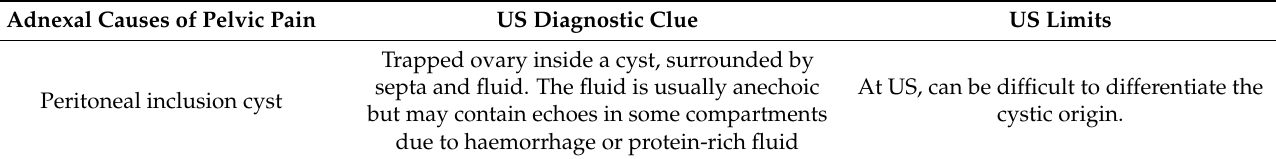
Figure 10. Peritoneal inclusion cyst. TSA–US axial scan ( a ) shows an irregular, anechoic para-adnexal right fluid collection (( a ) arrows). Axial T2w MRI ( b ) shows a large, well-defined multilocular cystic pelvic mass (arrows). Note several thin internal septa, radiating from the ovary, representing pelvic adhesions. The septa radiate from the ovary (star; ( b )). U: uterus. Peritoneal inclusion cysts must also be differentiated from hydrosalpinx, which appears as a tubular or ovoid cystic formation, with visible folds, with no ovary inside of it (Table 8) [1,19–21]. Table 8. Peritoneal inclusion cyst US diagnostic clue.